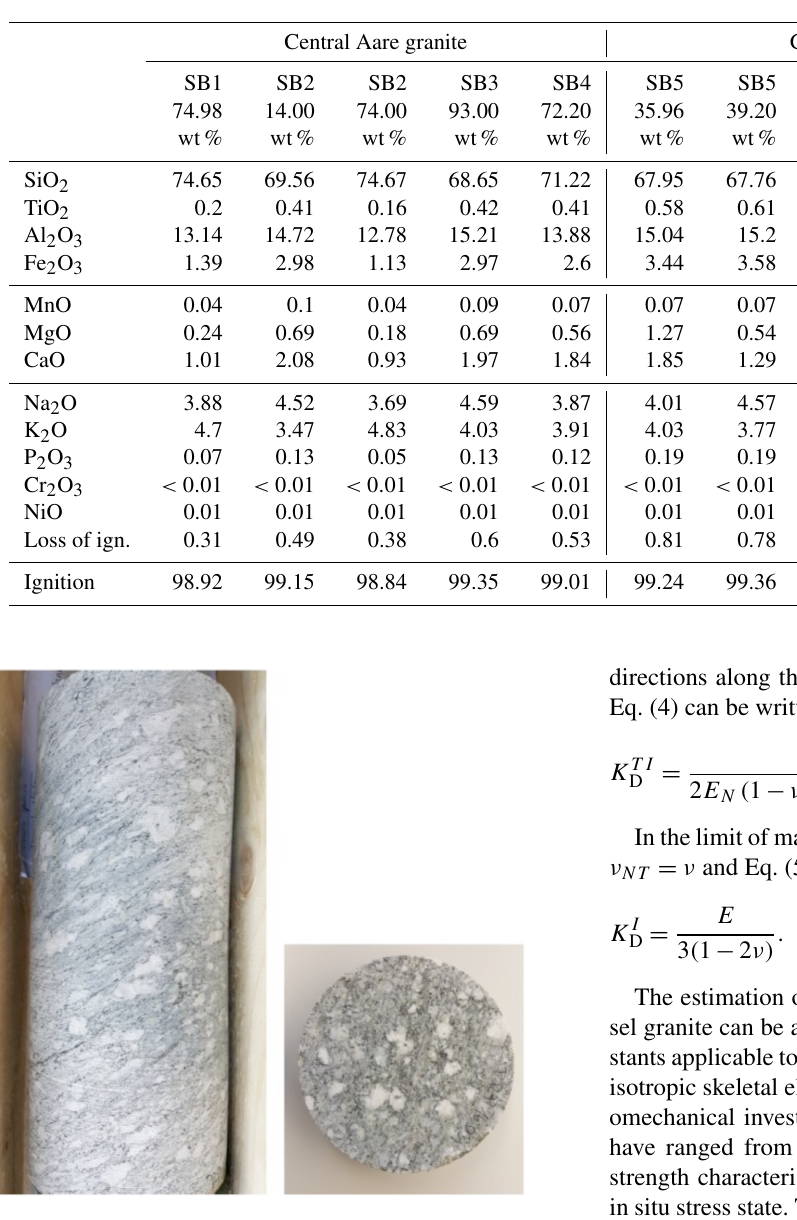
Figure 2. The Grimsel granite sample taken from the PRP1 bore- hole, with a diameter of 110mm and a length of 240mm. The nom- inal planes of stratification are inclined at about 50 ◦ to the axis of the